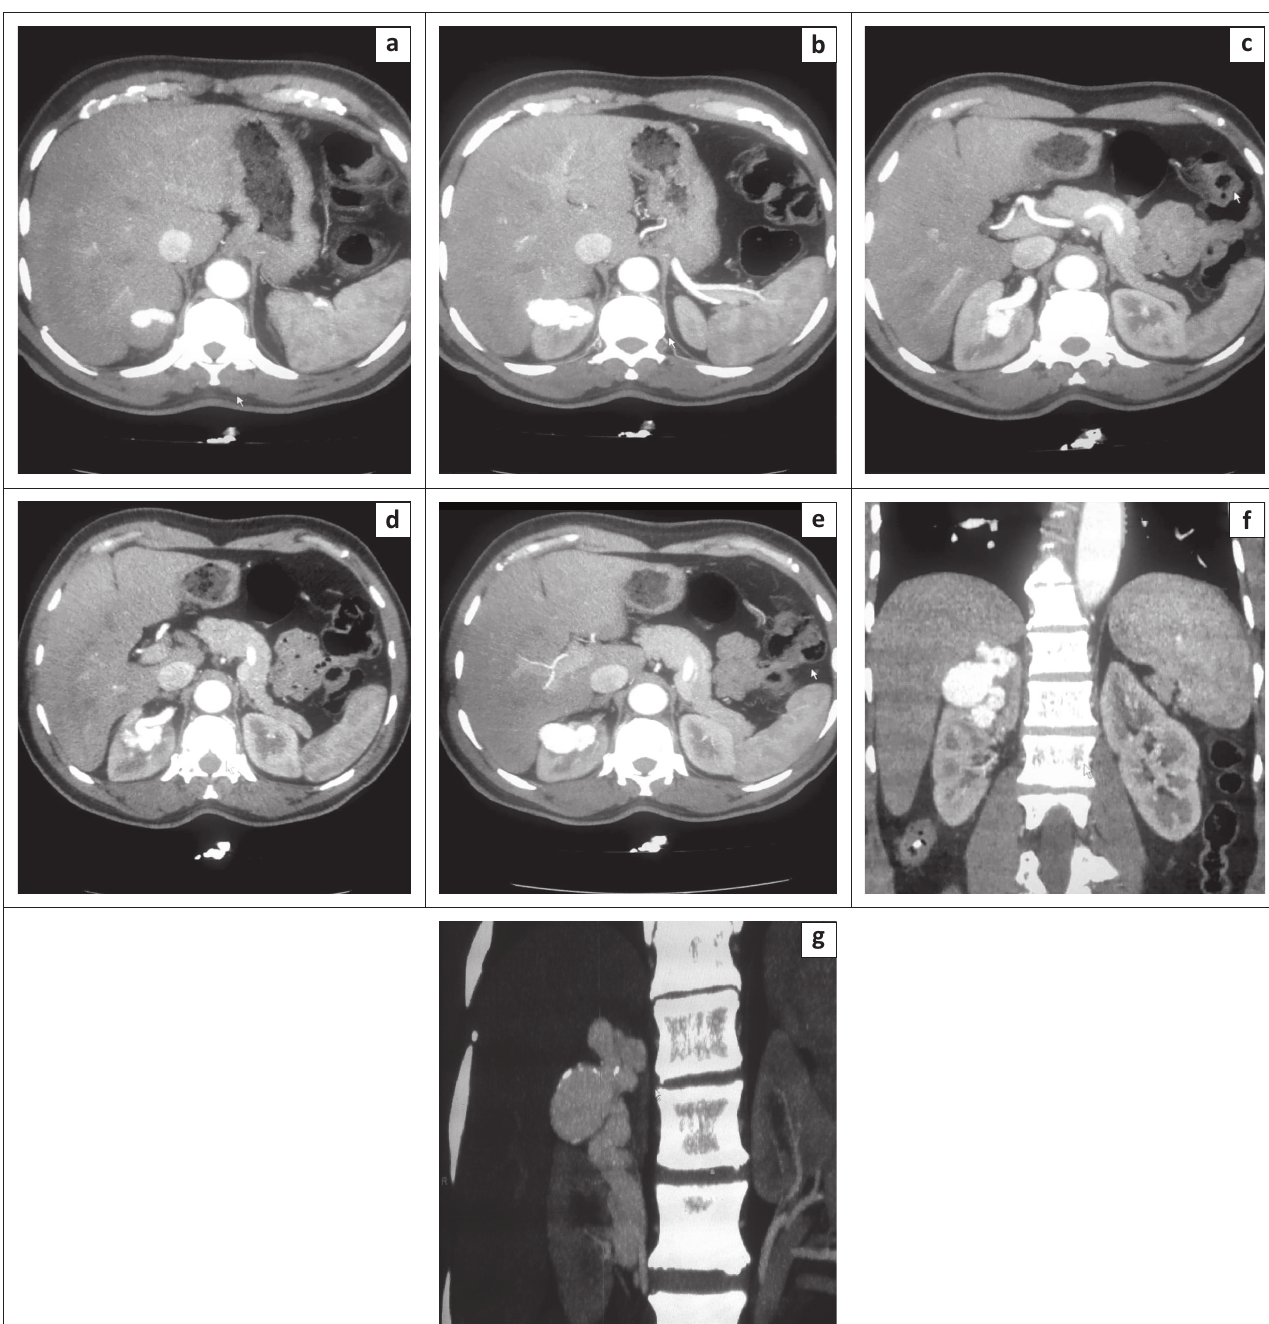
FIG URE 2: Computed tomography demonstrating the right upper pole arteriovenous malformation: (a–e) Axial plane images during arterial phase outline a single dilated upper pole segmental branch of the renal artery and immediate filling of the dilated draining vein; (f) Coronal plane images during arterial phase show a single dilated upper pole segmental artery and rapid filling of a single aneurysmal draining vein without any nidus; (g) Multi planar reconstruction in the coronal plane outlining the dilated right main renal artery and its upper pole segmental branch, a single dilated, tortuous draining vein and aneurysmal dilatation at the site of arterial